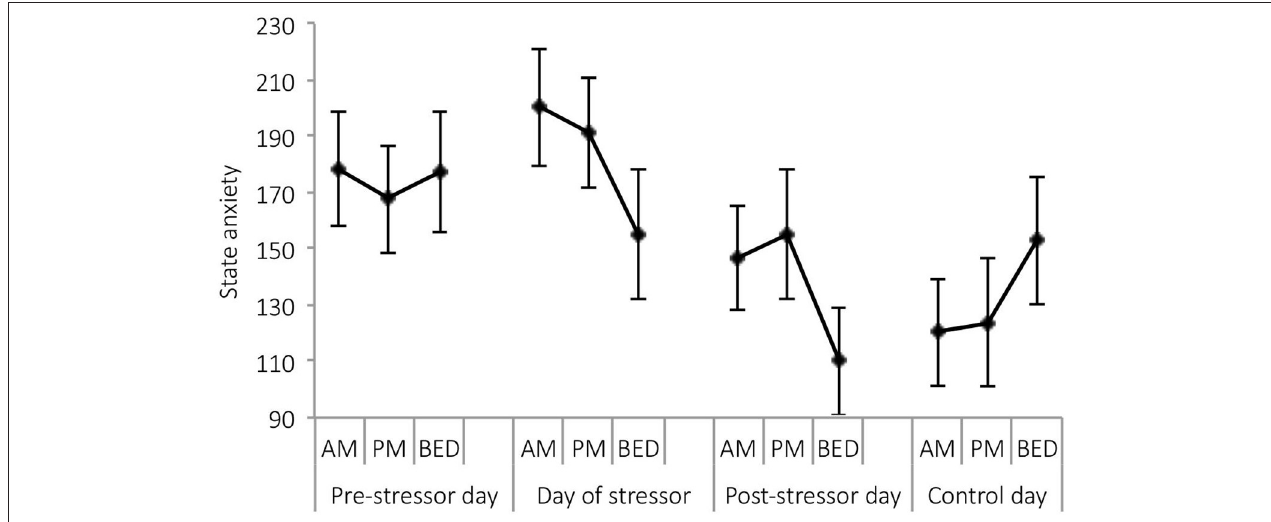
FIGURE 5 | Mean (and SE) state anxiety assessed in the morning, at waking + 6h and bedtime, over the four sampling